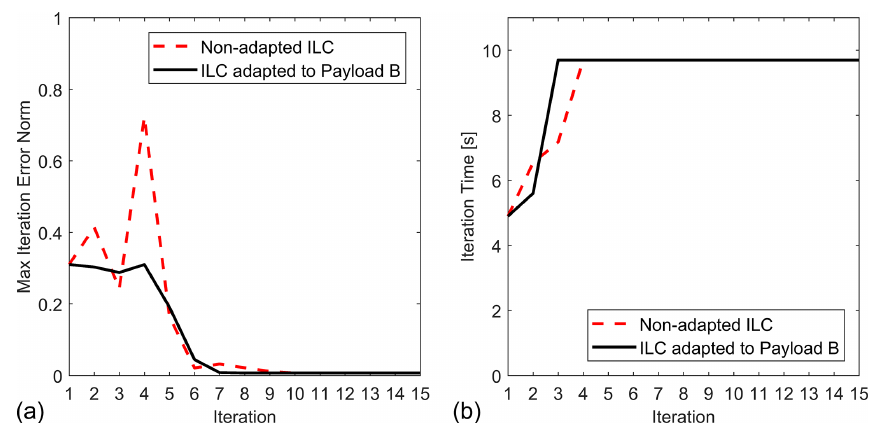
Figure 9. Convergence comparison of the ILC process for Trajectory E with Payload B for non-adapted ILC and ILC adapted to Payload B: (a) maximum tracking error and (b) iteration times.